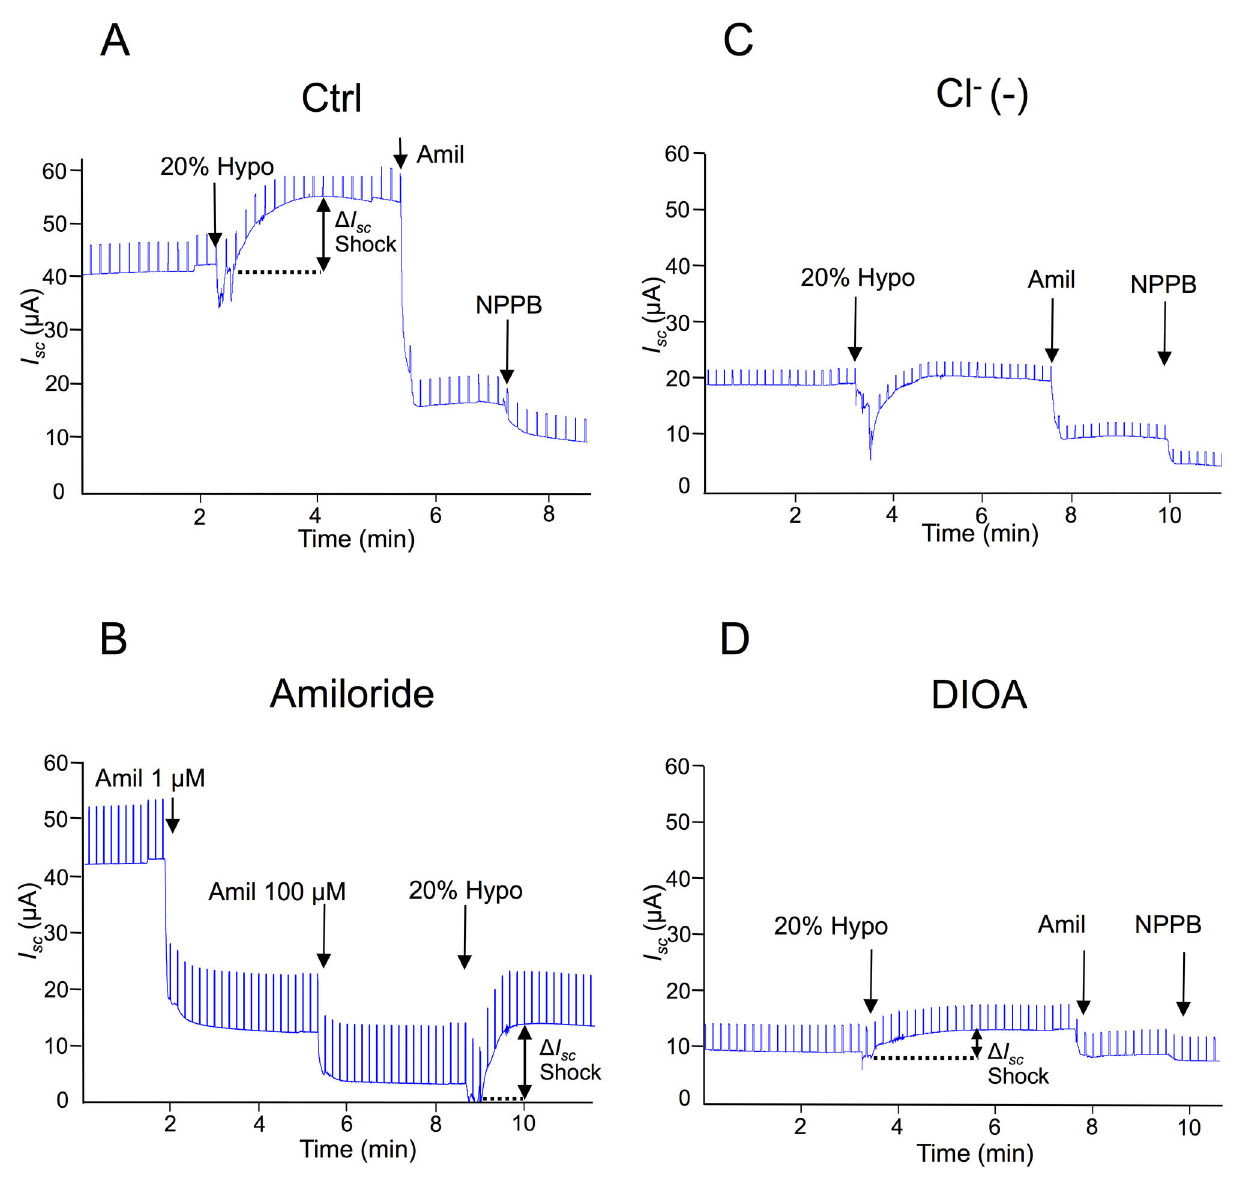
Figure 2. Impact of 20% hypotonic shock on the Ussing I 20% hypotonic shock (20% Hypo) in the basal condition (Ctrl) A , after 100 µM amiloride pre-treatment (Amiloride) B , in reduced Cl - buffer (9mM NaCl; 150 mM Na gluconate) (Cl - (-)) C or after 100 µM basolateral DIOA treatment D . Arrows show the start of hypotonic shock (20% Hypo) and the apical addition of 10 µM amiloride (Amil), 1 µM amiloride (Amil 1), 100 µM amiloride (Amil 100) or 100 µM NPPB. A double-headed arrow shows the current rise elicited by hypotonic shock (Δ I